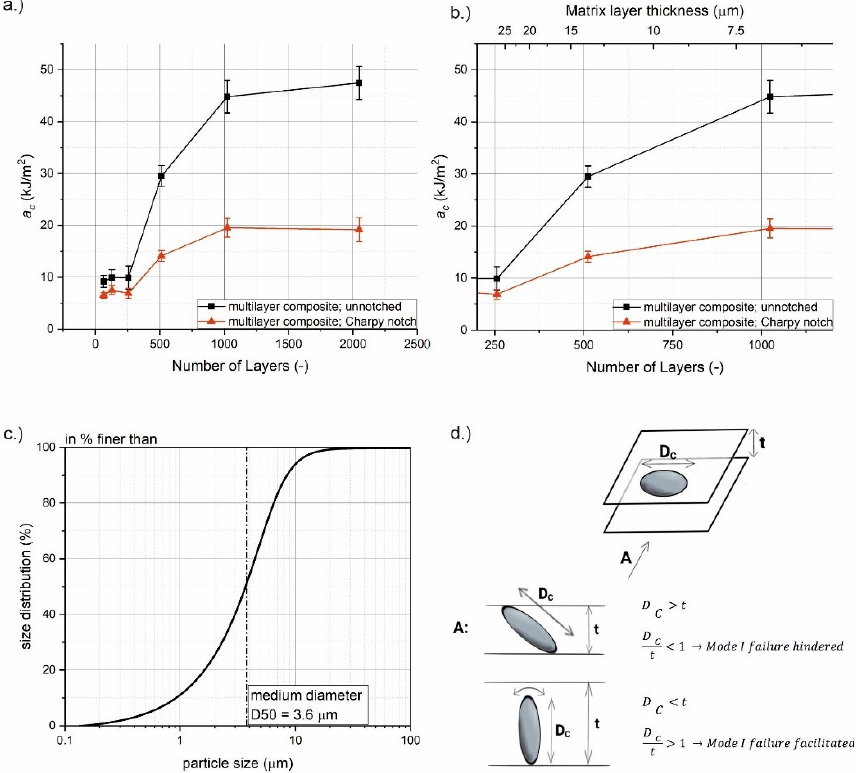
Figure 2. ( a ) Impact strength versus number of layers for a multilayer composite, ( b ) a magnifica- tion of the plateau region, ( c ) the size distribution of the talcum particles in the matrix and ( d ) a representation of large talcum particle orientation in a thin matrix